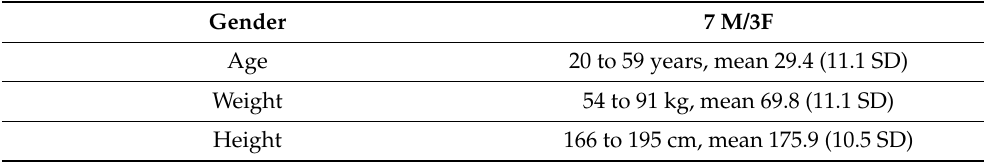
Table 2. Baseline demographic data of study participants.